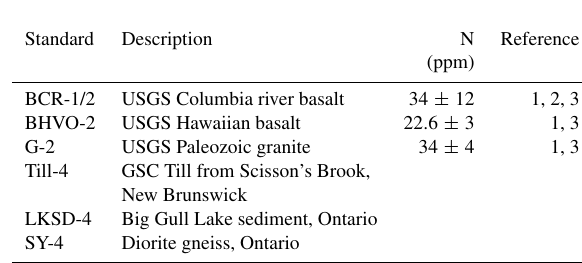
Table 1. Rock standards from the United States Geological Sur- vey (USGS) and Geological Survey of Canada (GSC) analyzed with published values, if available, and N analysis